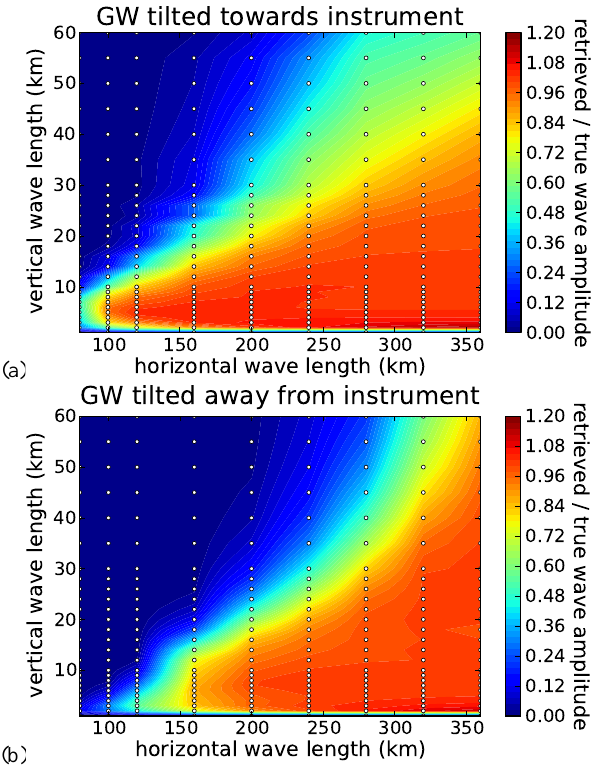
Fig. 9. Observational filter for the PREMIER IRLS. Depicted is the ratio of retrieved wave amplitude to true wave amplitude for the baseline retrieval setup with varying modulated waves. Anal- ysed wavelength combinations are indicated with white circles. (a) shows the filter for the baseline setup with waves tilted towards the instrument. (b) shows the filter for a negative horizontal wave num- ber (i.e. waves tilted away from the instrument).